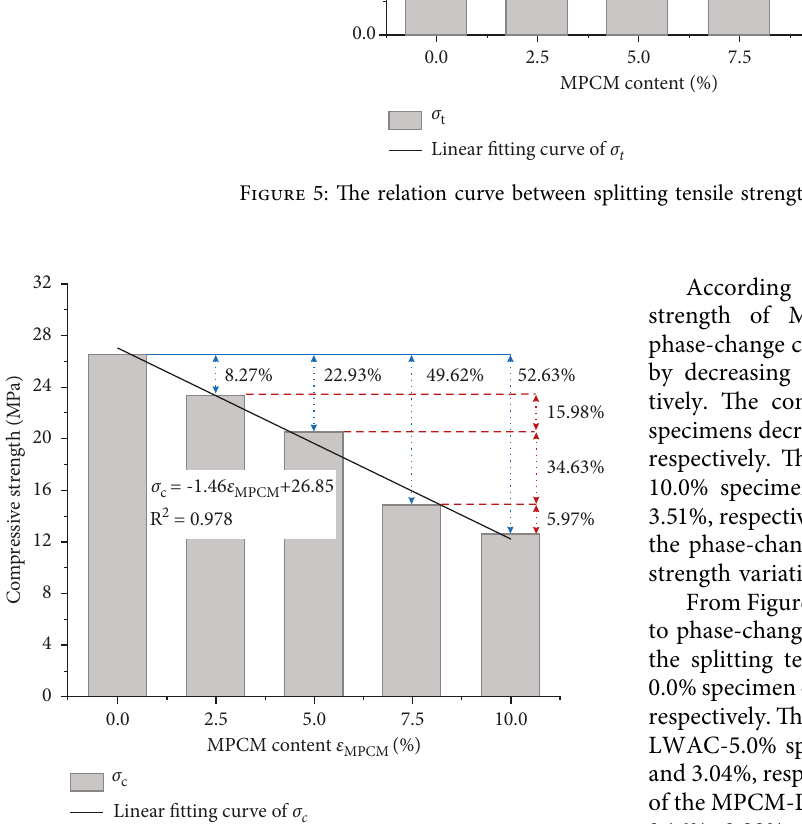
Figure 6: The relation curve between compressive strength and MPCM